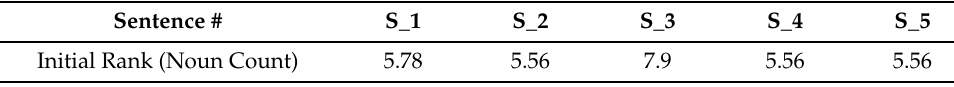
Table 4. Modified Text Rank: node score after iteration 1.